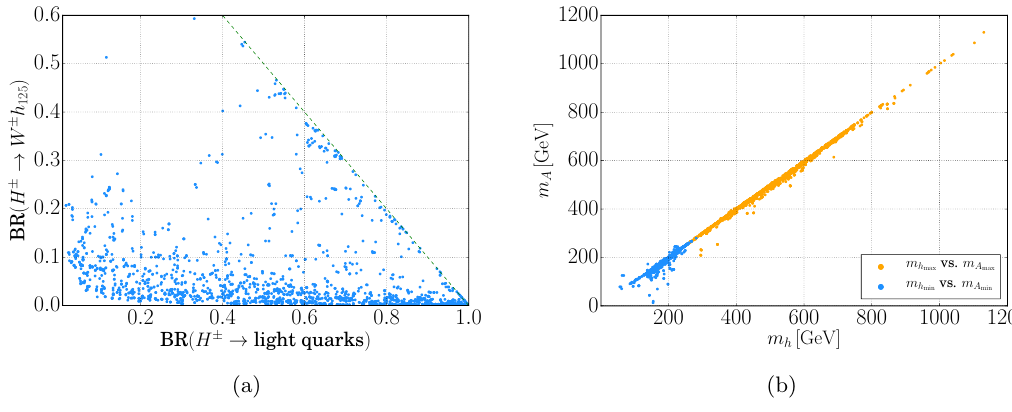
Figure 6 . (a) BR( H + W + h 125 ) vs. BR( H + light quarks). Here, ‘light quarks’ refers to 1st ! ! and 2nd generation quarks. The dashed line represents when BR( H + W + h 125 ) + BR( H + ! ! light quarks) = 1, i.e. when these two channels dominate the total decay width. For almost all points far away from this line, the lightest charged Higgs often decays to W (cid:6) h a ; b . (b) Scalar vs. pseudo-scalar masses for the lightest (blue) and heaviest (orange) states. The alignment of these masses is consistent with the (cid:24) 1 expansion. (cid:28)